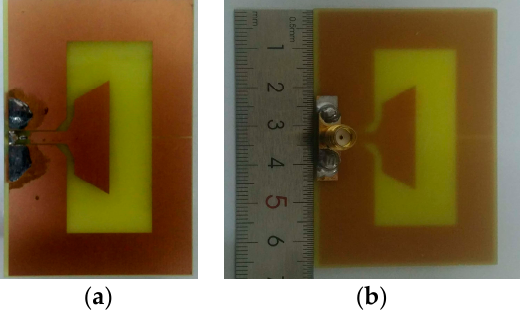
Figure 10. Prototype of the proposed BRA: ( a ) front view; ( b ) back view.